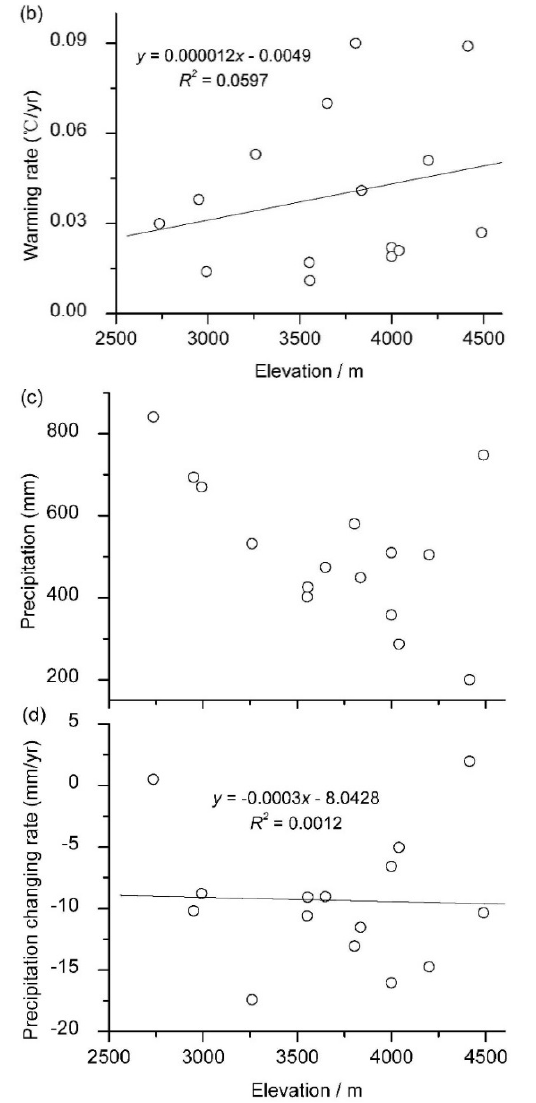
Figure 5. Variations of annual mean temperature ( a ), warming rate ( b ), annual precipitation ( c ), and precipitation changing rate ( d ) against elevation from 2500 m to 4500 m, respectively, during 1999–2013. Each circle represents one value from each meteorological station in the YZR basin.